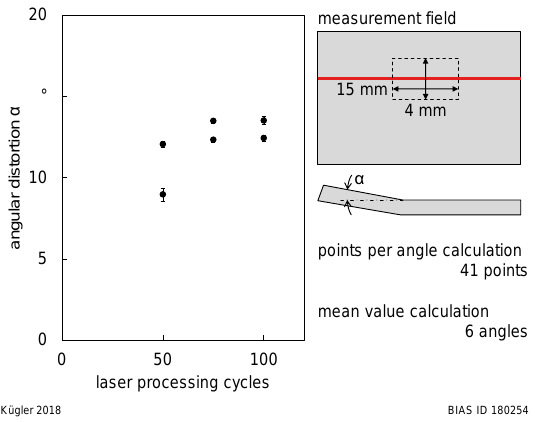
Figure 7. Angular distortion after laser processing.